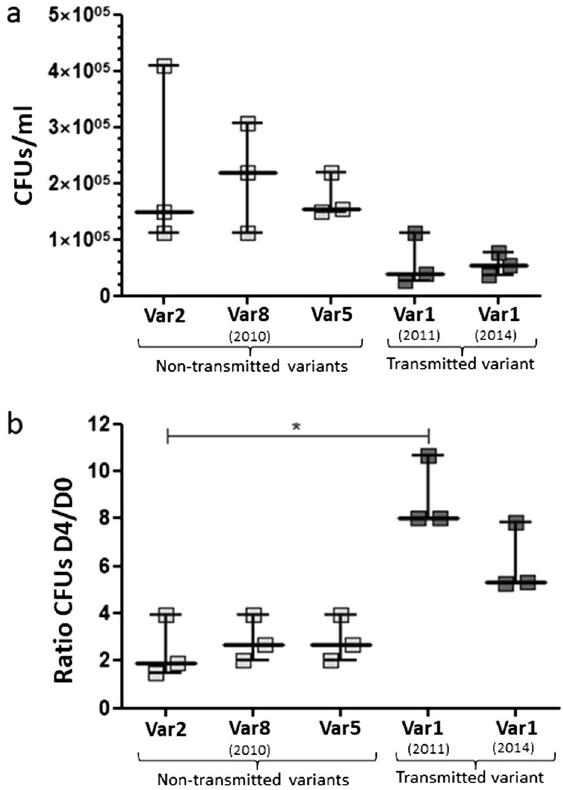
Figure 3. ( a ) Macrophage invasiveness (CFUs at Day 0) for the five selected variants. Each square represents the mean value of an experiment. Lines and error bars indicate median values ± range. ( b ) Intramacrophage multiplication ratios (CFUs at Day 4/CFUs at Day 0) for the five selected variants. Each square represents the mean value of an experiment. Lines and error bars indicate median values ± interquartile range. * p < 0.05.